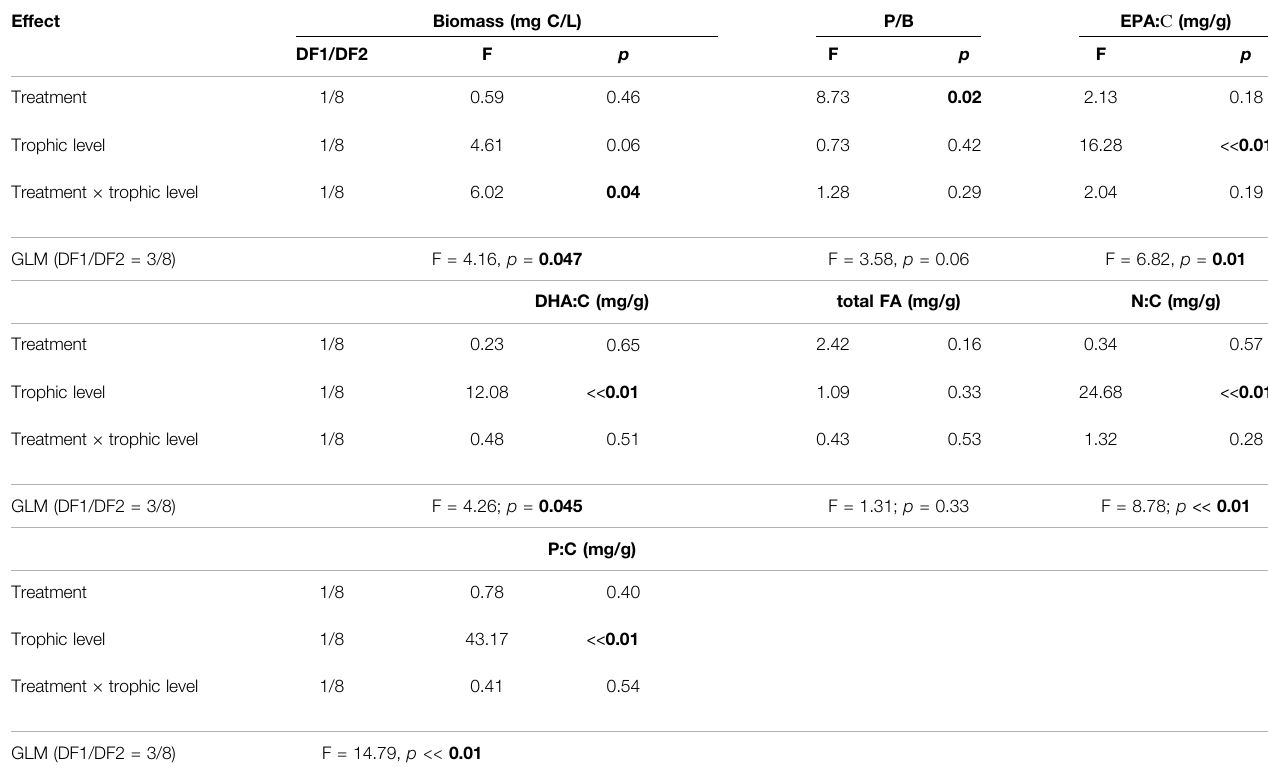
TABLE 2 | Results of GLM two-way ANOVA for biomass, P/B ratios, and contents of substances on day 30 in the 2017 experiments.